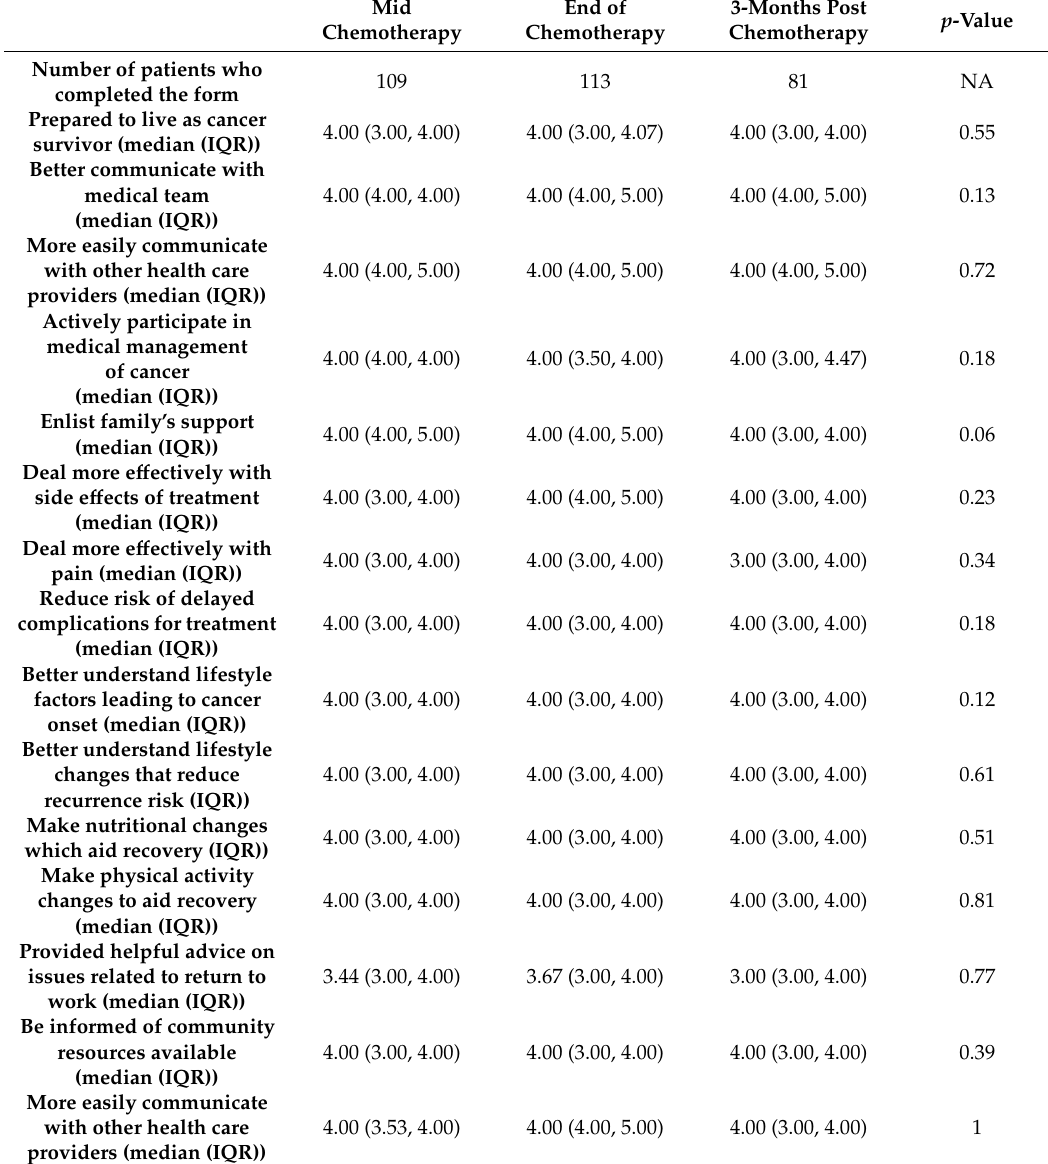
Table 2. Level of agreement reported by patients regarding satisfaction with the personalized treatment and care